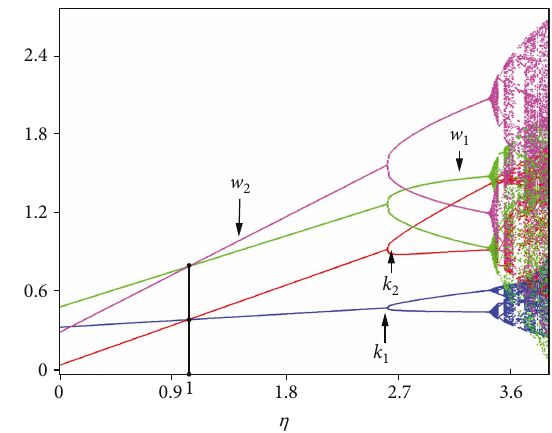
η ∈ 0, 3 80 . 1 , k 2 , w 1 , w 2 when